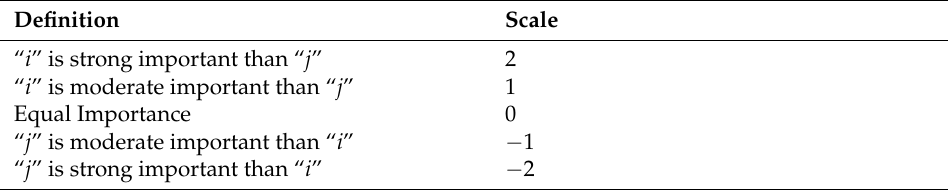
Table 3. The interpretation of the − 2~2